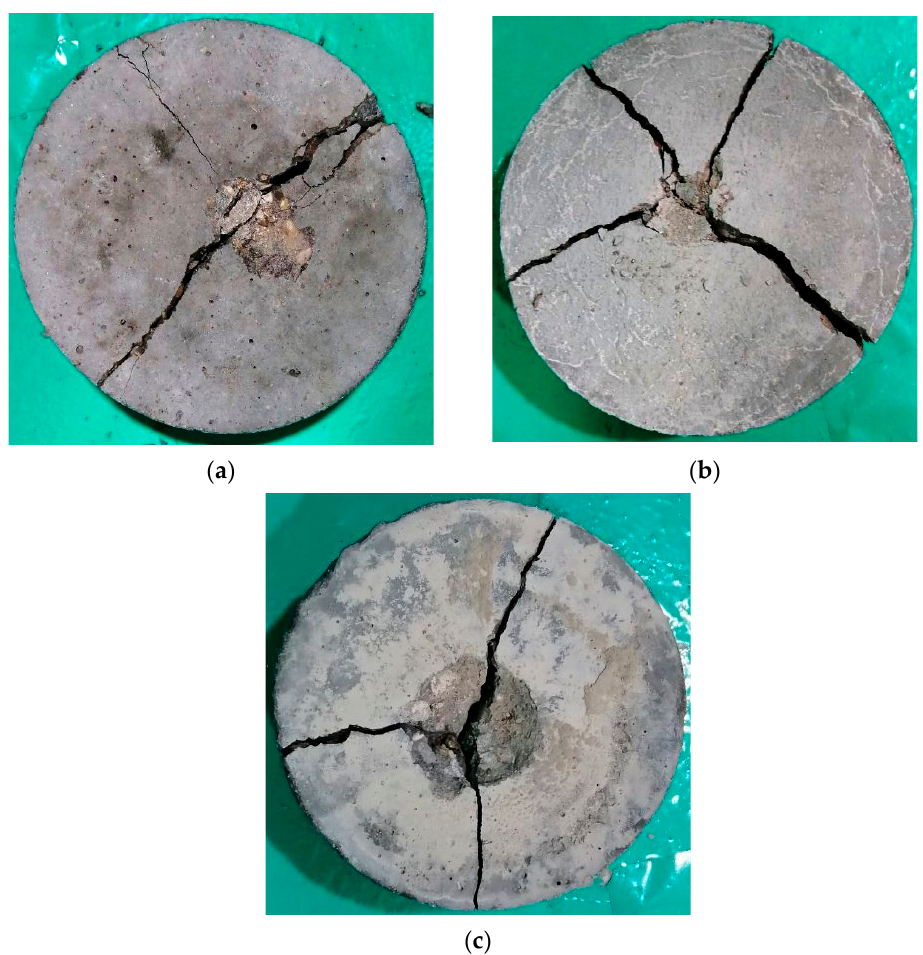
Figure 14. Failure patters of unheated cylindrical specimens: ( a ) M20, ( b ) M40, ( c ) M80.